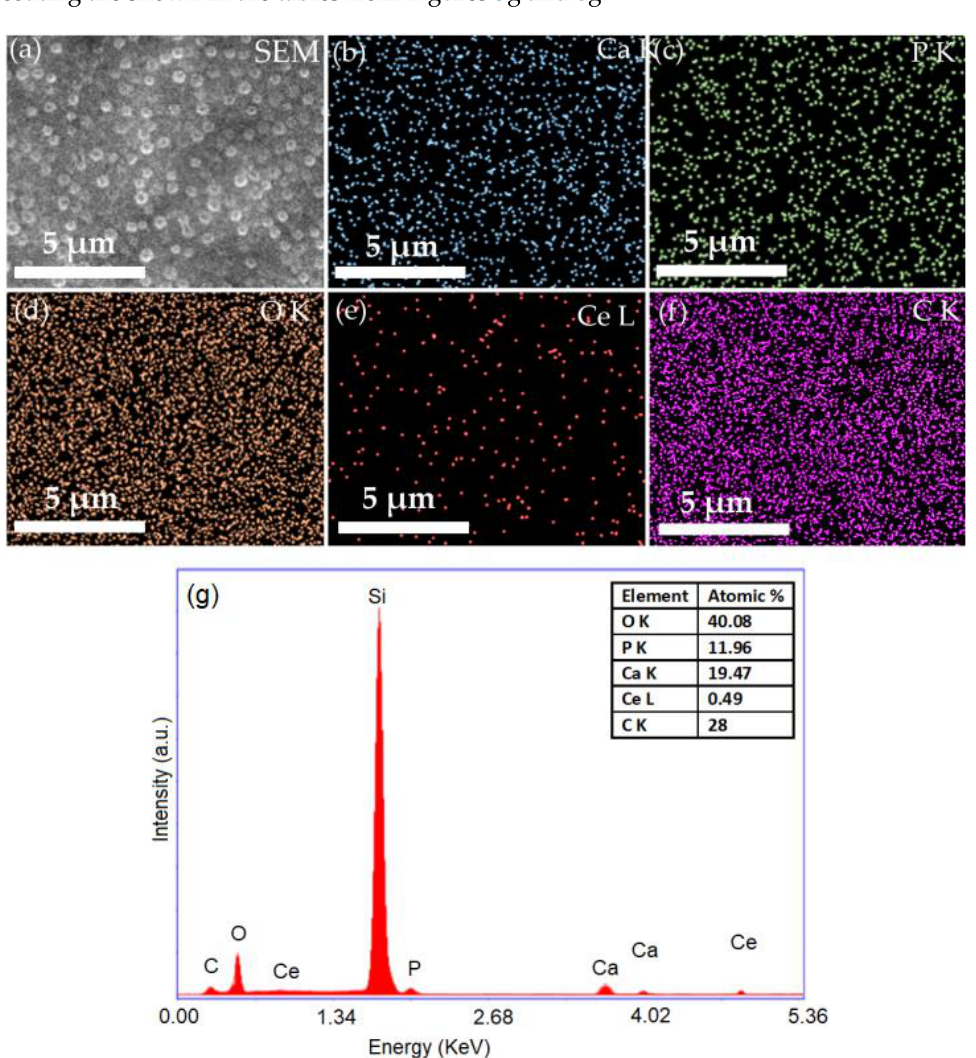
Figure 5. SEM image ( a ), EDS elemental mapping of the constituent elements of 5CeHAp-D composite coating ( b – f ) and EDS spectrum of 5CeHAp-D composite coatings ( g ).